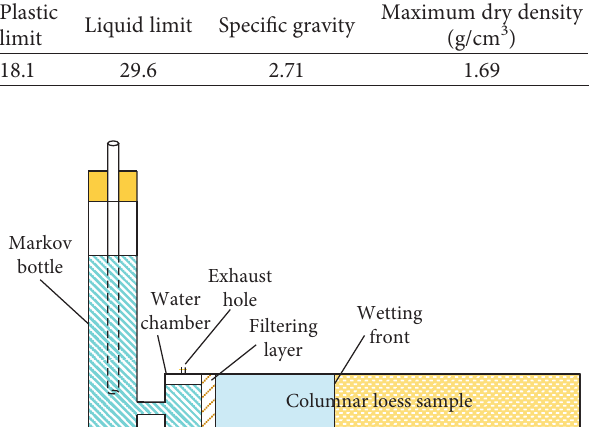
Table 1: Physical parameters of loess samples.